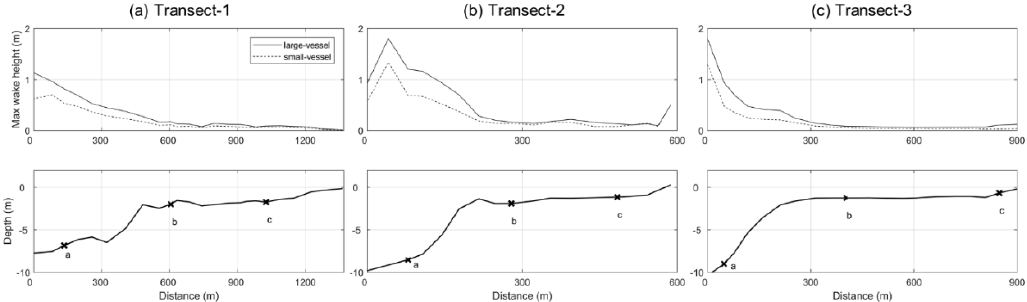
Figure 7. Cross shore profiles of maximum wake height (top panels; solid lines for experiments with large vessel and dashed lines for small vessel) and bathymetry (bottom panels) along transects 1, 2, and 3. Results are for single vessel experiments with a speed of 15 knots. Points a, b, and c are the locations of model output stations.